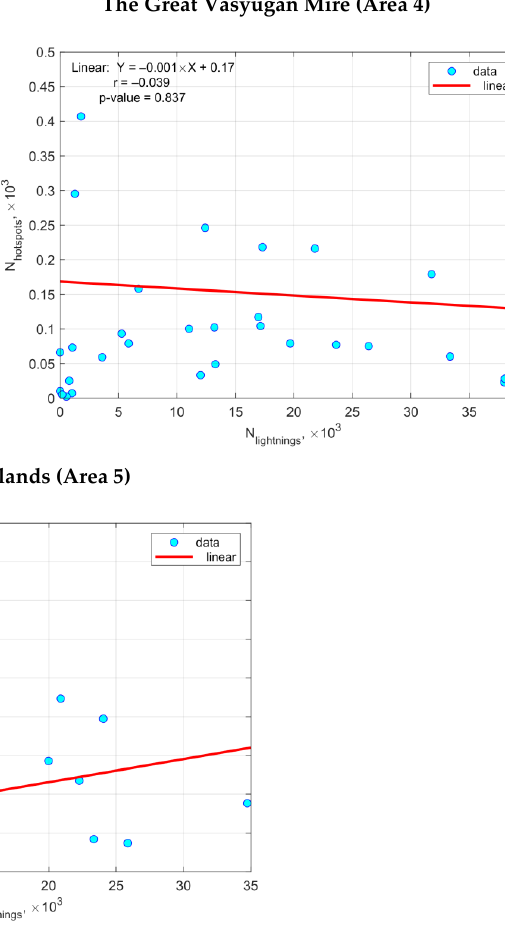
Figure 6. Relationship between the total number of hotspots and the total number of lightning strikes per warm season (May – September) in Western Siberia from 2016 to 2021. Practically, in most considered areas (besides Area 3 and Area 4) of Western Siberia, the relationship between lightning and hotspots is positive, however, values of correlation coefficients ( r ) are statistically insignificant (α = 0.05). The highest values ( r varies up to 0.32) are observed in the northern part of the region (Areas 1 and 5).